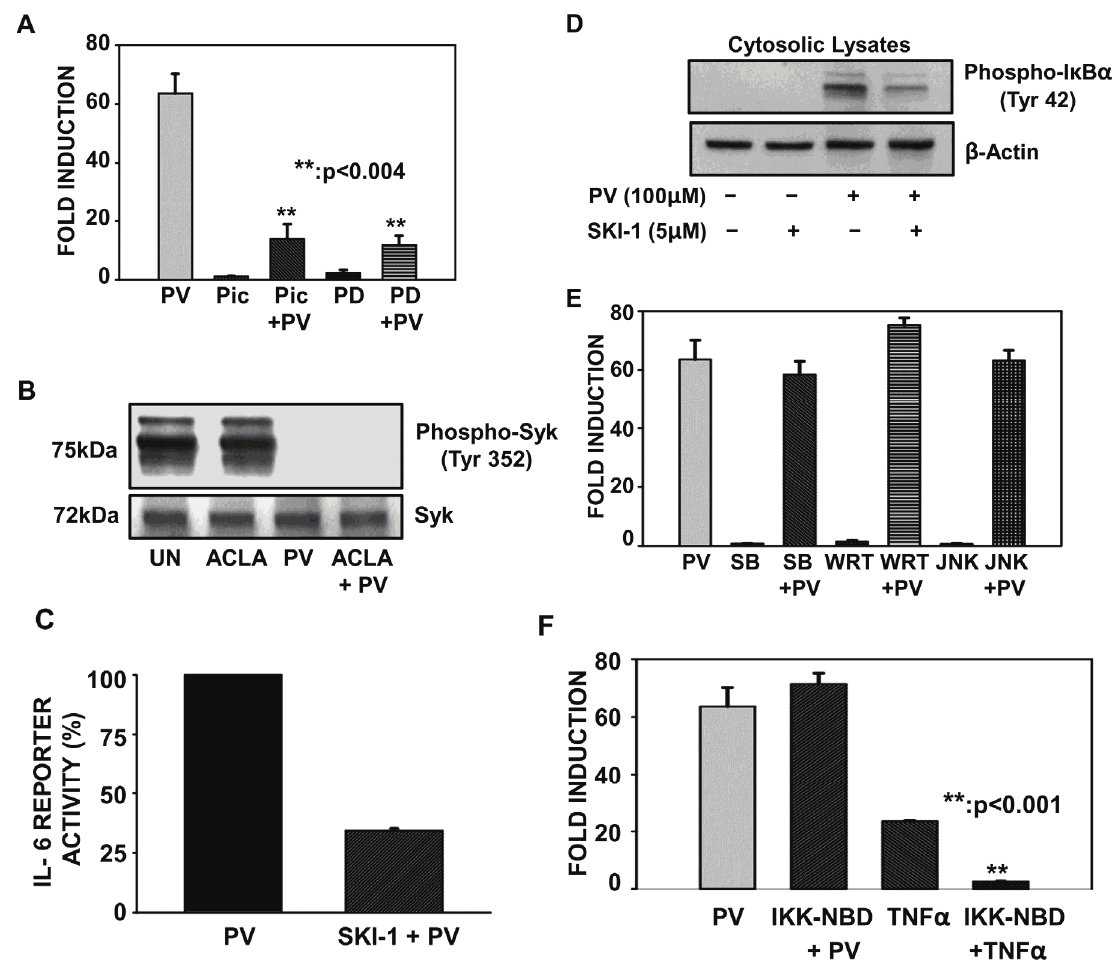
Figure 2. Pretreatment with inhibitors of Src and mitogen-activated protein kinase kinase (MEK) but not p38, PI3K, c-Jun N-terminal kinase (JNK) and IkappaB kinase (IKK) complex interfere with PV-induced NF-(cid:2)B activity. ( A ) ILU-18 cells were pretreated with 75 μM Piceatannol (Pic.) for 45 min or 20 μM PD98059 (PD.) for 30 min followed by activation with 100 μM pervanadate for 18 h. Cells treated with 100 μM pervanadate, 75 μM Piceatannol, or 20 μM PD98059 for 18 h, served as controls. At the end of 18 h, lysates were obtained and luciferase activity was determined employing the Promega luciferase assay kit. Fold induction represents a ratio of luciferase activity obtained in treatment-induced to that of untreated cells. Data represents mean ± standard error obtained from four independent experiments, following normalization. ** Denotes significant difference at p < 0.004, between treatment groups. ( B ) ILU-18 cells were treated with PV (100 (cid:4)M) for 20 min, with or without prior treatment with Aclacinomycin (0.25 (cid:4)M) for 2 h. At the end of incubation, cells were washed and cytosolic lysates prepared. As controls, cell lysates were made from ILU-18 cells left untreated or treated 140 min with 0.25 (cid:4)M Aclacinomycin alone. Lysates, equalized for 30 (cid:4)g protein, were resolved using SDS-PAGE, followed by Western blotting using antibodies for phospho-Syk (Tyr-352) and, as a control, Syk. ( C ) ILU-18 cells were treated with 100